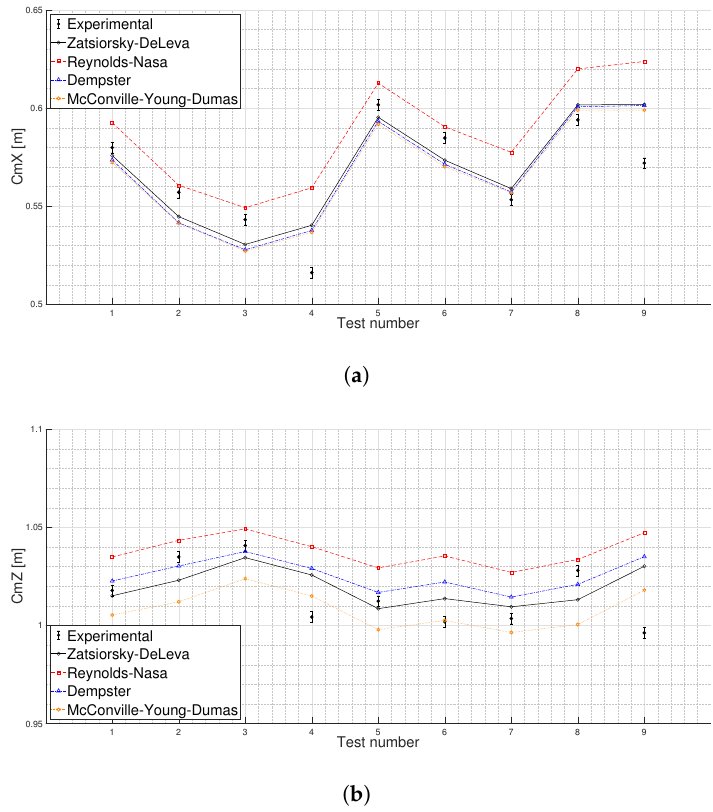
Figure 3. Horizontal ( a ) and vertical ( b ) position of G : numerical vs.